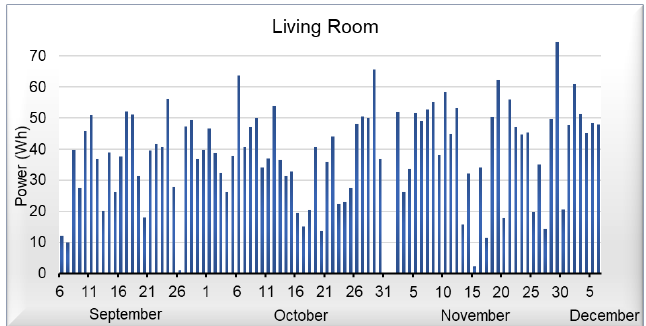
Figure 10. Power consumed by the portico light.